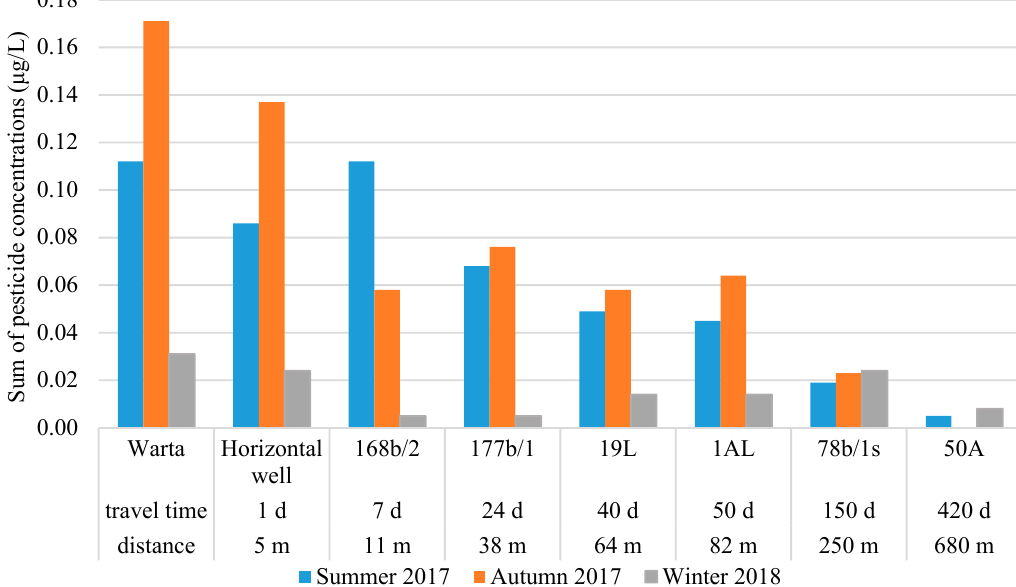
Figure 8. The sum of pesticide concentrations along the flow path.